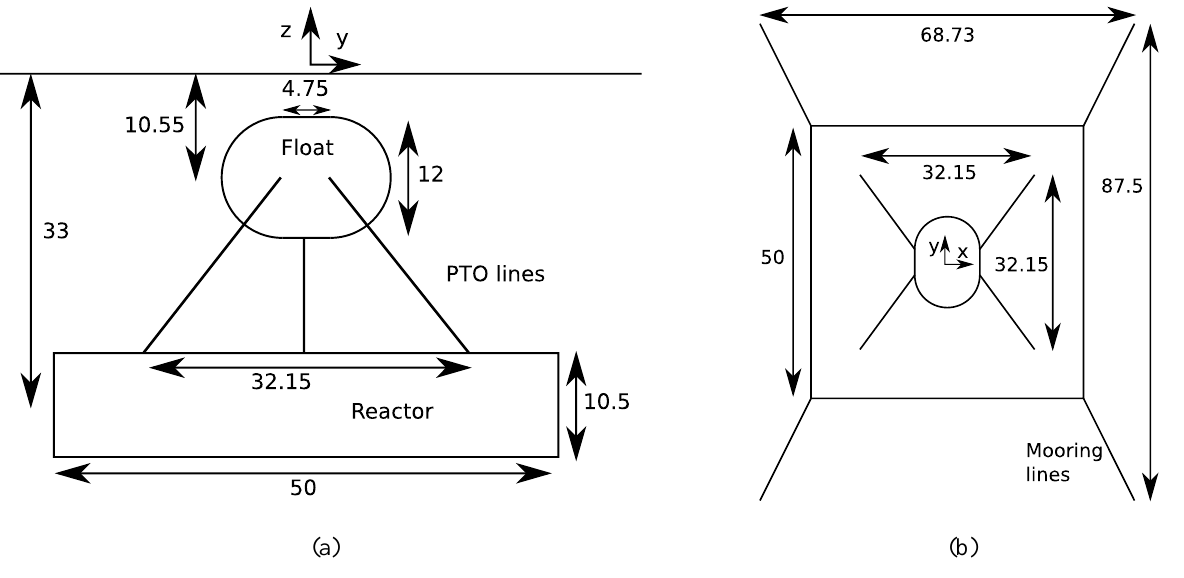
Fig. 4: Schematic of the WaveSub